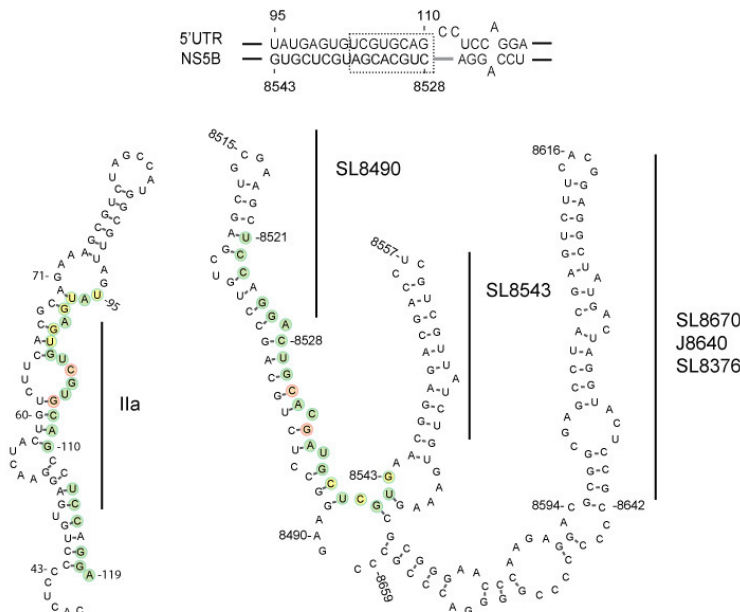
Figure 1. Depiction of minimum free energy duplex model (top panel) and stem-loop structure plots for the IRES domain II (bottom left) and NS5B region 8490–8659 (bottom right). Domain IIa and NS5B sequence pairings (bottom, shaded circles), small mutation SM constructs (red), large mutation LM constructs (red and yellow) and adjacent stem-loop SL8670/J8640/8376 are shown [15].